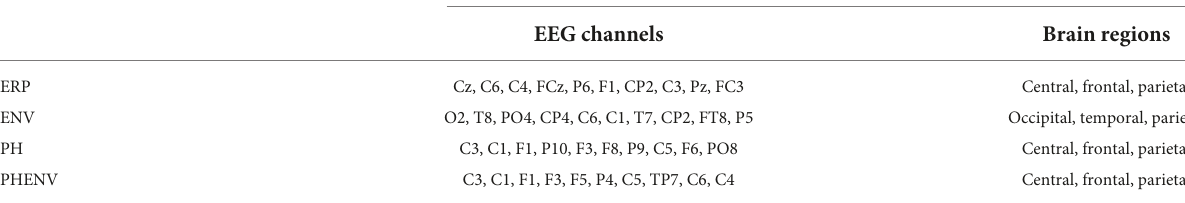
TABLE 4 Summary of regions of significant contribution for deep learning. The ten most significant EEG channels and their regions, to predict speech intelligibility, are selected using occlusion sensitivity